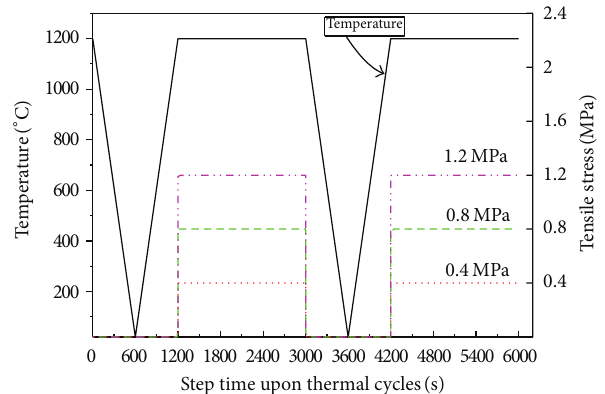
Figure 4: The temperature and mechanical load sequence upon thermal